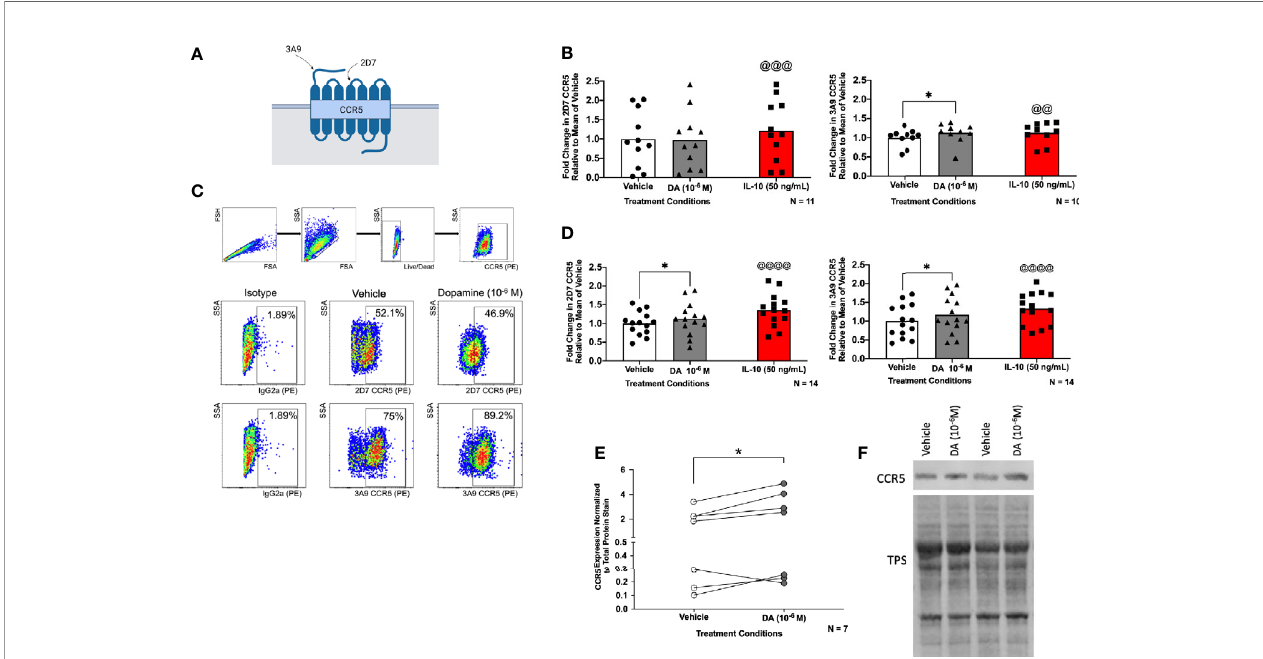
FIGURE 3 | Dopamine alters the proportion of CCR5 conformations in hMDM. Surface expression of 2D7 (ECL2) and 3A9 (NT) CCR5 as depicted in (A) (created with BioRender.com) was analyzed by fl ow cytometry after hMDM were treated with vehicle (diH 2 O), dopamine (10 -6 M), or IL-10 (50 ng/mL) as a positive control (N= 10-11, donors are not the same for each analysis) for 1 hour (B) . The separate statistical tests performed on the IL-10-treated samples are denoted by the use of the @ sign, rather than the * used to show signi fi cance in the analyses of dopamine-mediated changes. Fold change in CCR5 is relative to the mean of the